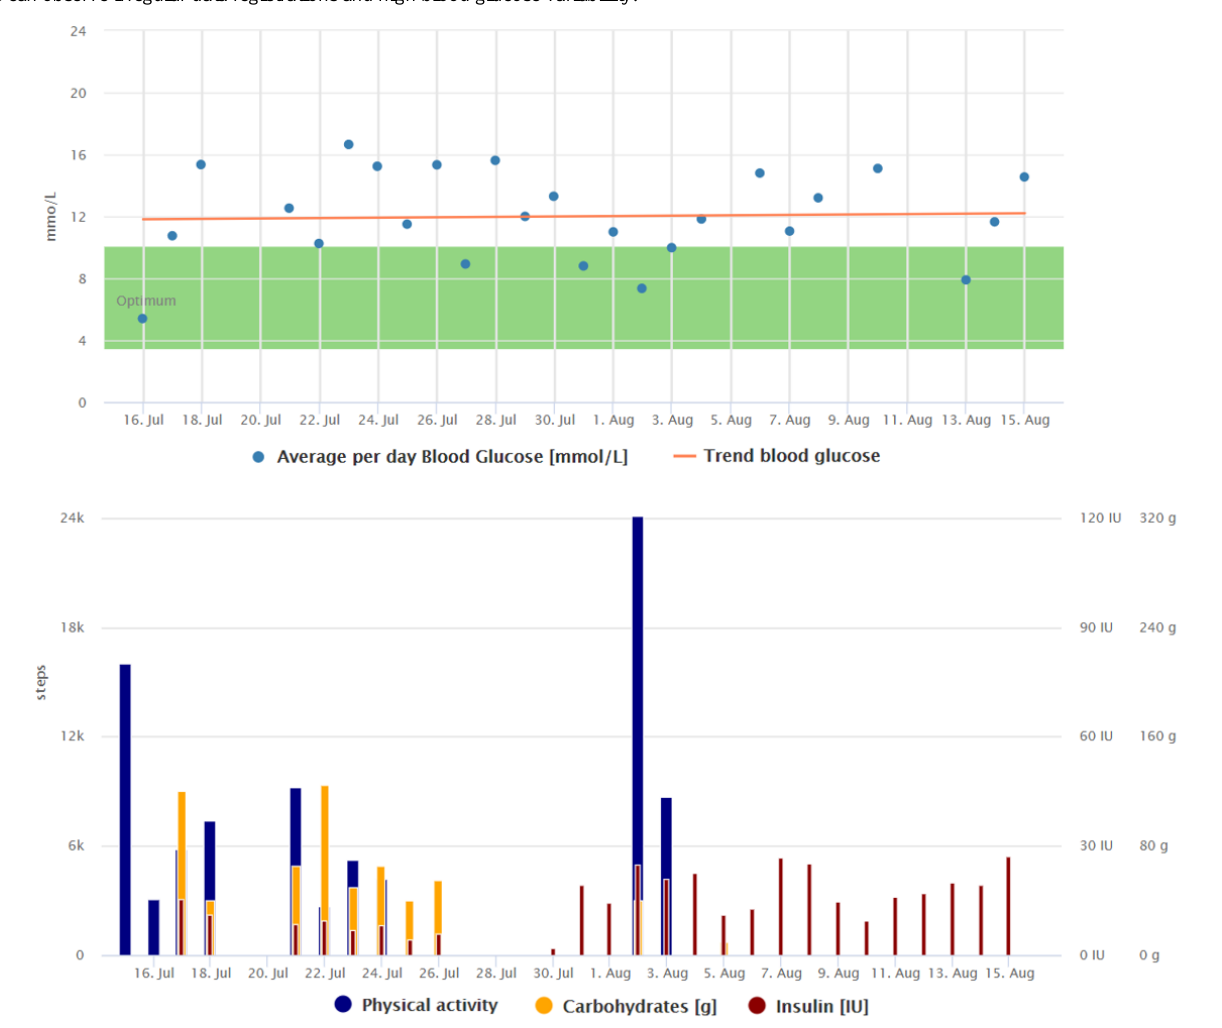
Figure 5. Graphical interpretation of 1-month data registrations of the patient from the case study 4, visualized by the Diani Web app. In the picture, we can observe irregular data registrations and high blood glucose